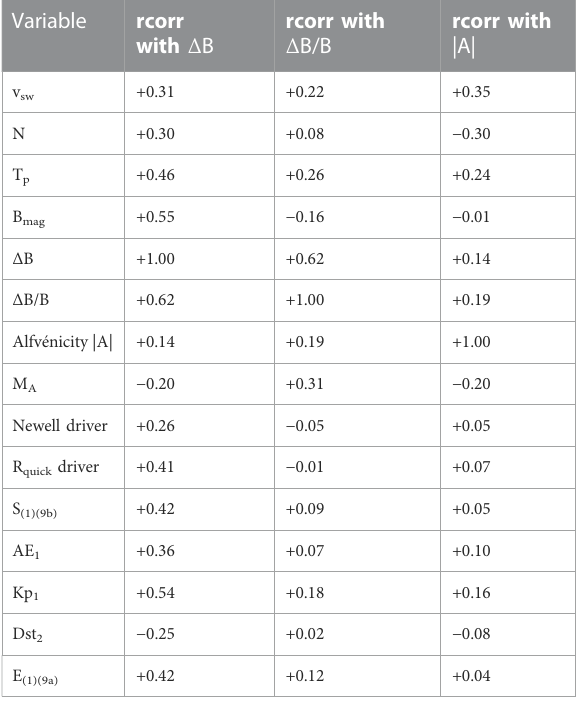
TABLE 1 Correlation coef fi cients between relevant variables and Δ B = < (B- < B > ) 2 > 1/2 , Δ B/B, and Alfvénicity |A|. The Alfvénicity is calculated using the ACE data in the years 1998 – 2008, other correlations use the OMNI2 dat in the years 1998 – 2012.